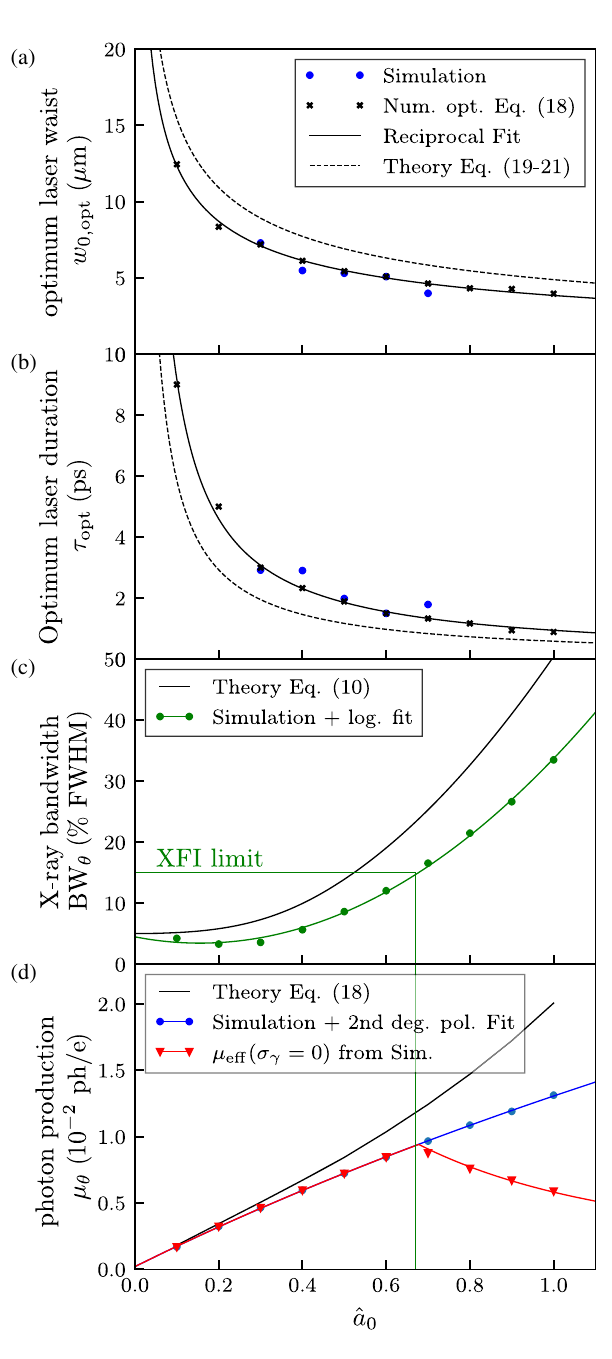
FIG. 6. Variation of ˆ a 0 with μ θ -optimized τ , w 0 and σ e determined via Eq. (18). The optimum laser waist w 0 (a) and pulse duration τ (b) as a function of ˆ a 0 . Theoretical opt optimization via Rayleigh-length matching [Eq. (19), (21)], via numerical optimization of Eq. (18) and the simulation results (markers) are compared. Bandwidth within 1 mrad BW θ (c) and the cone photon production μ θ (blue) and the effective μ (red) according to Eq. (8) for a simulated TS eff interaction with a monochromatic electron bunch (d). The XFI bandwidth limit of 15% for this scenario is included as green lines.